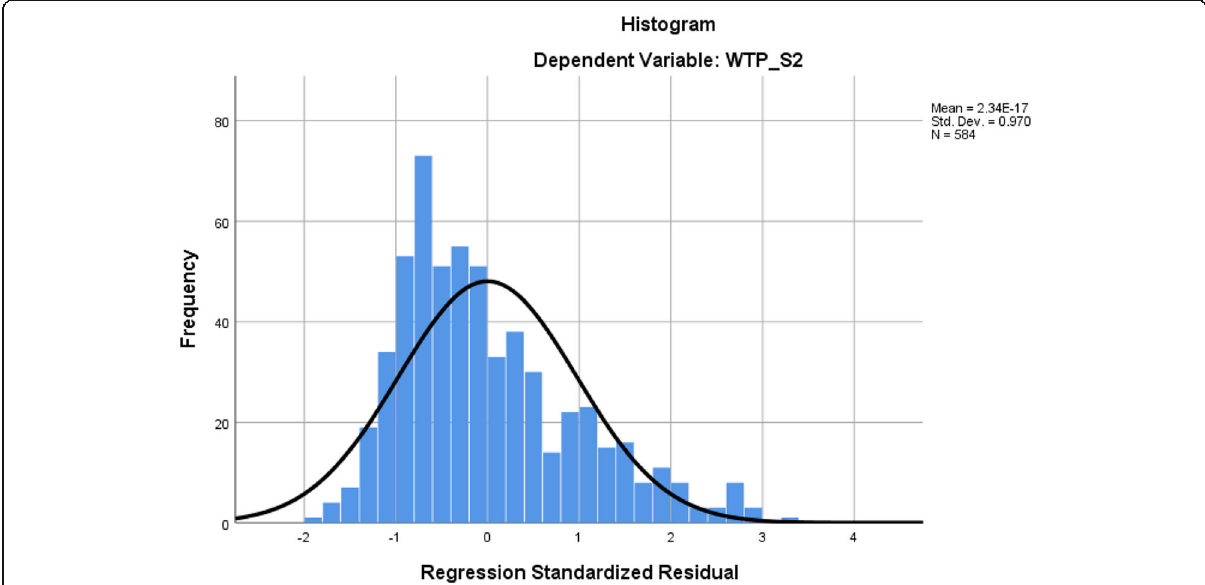
Fig. 9 Histogram of the residuals of regression of Model B (explanatory variables against WTP for SAV)